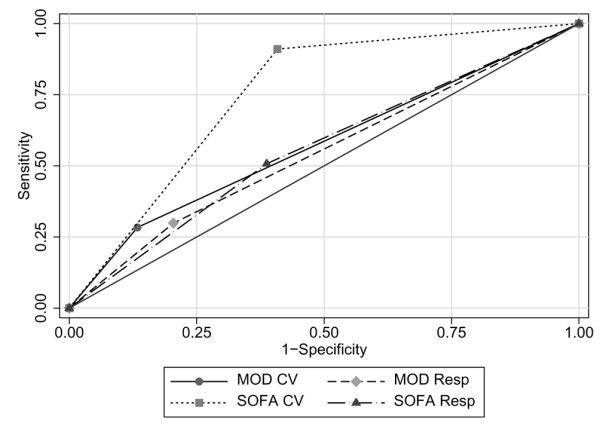
Area under the ROC curve for hospital mortality by SOFA and MOD score organ system failure. CV, cardiovascular; MOD Multiple Organ Dysfunction; ROC, receiver operating characteristic; SOFA, Sequential Organ Failure Assessment.